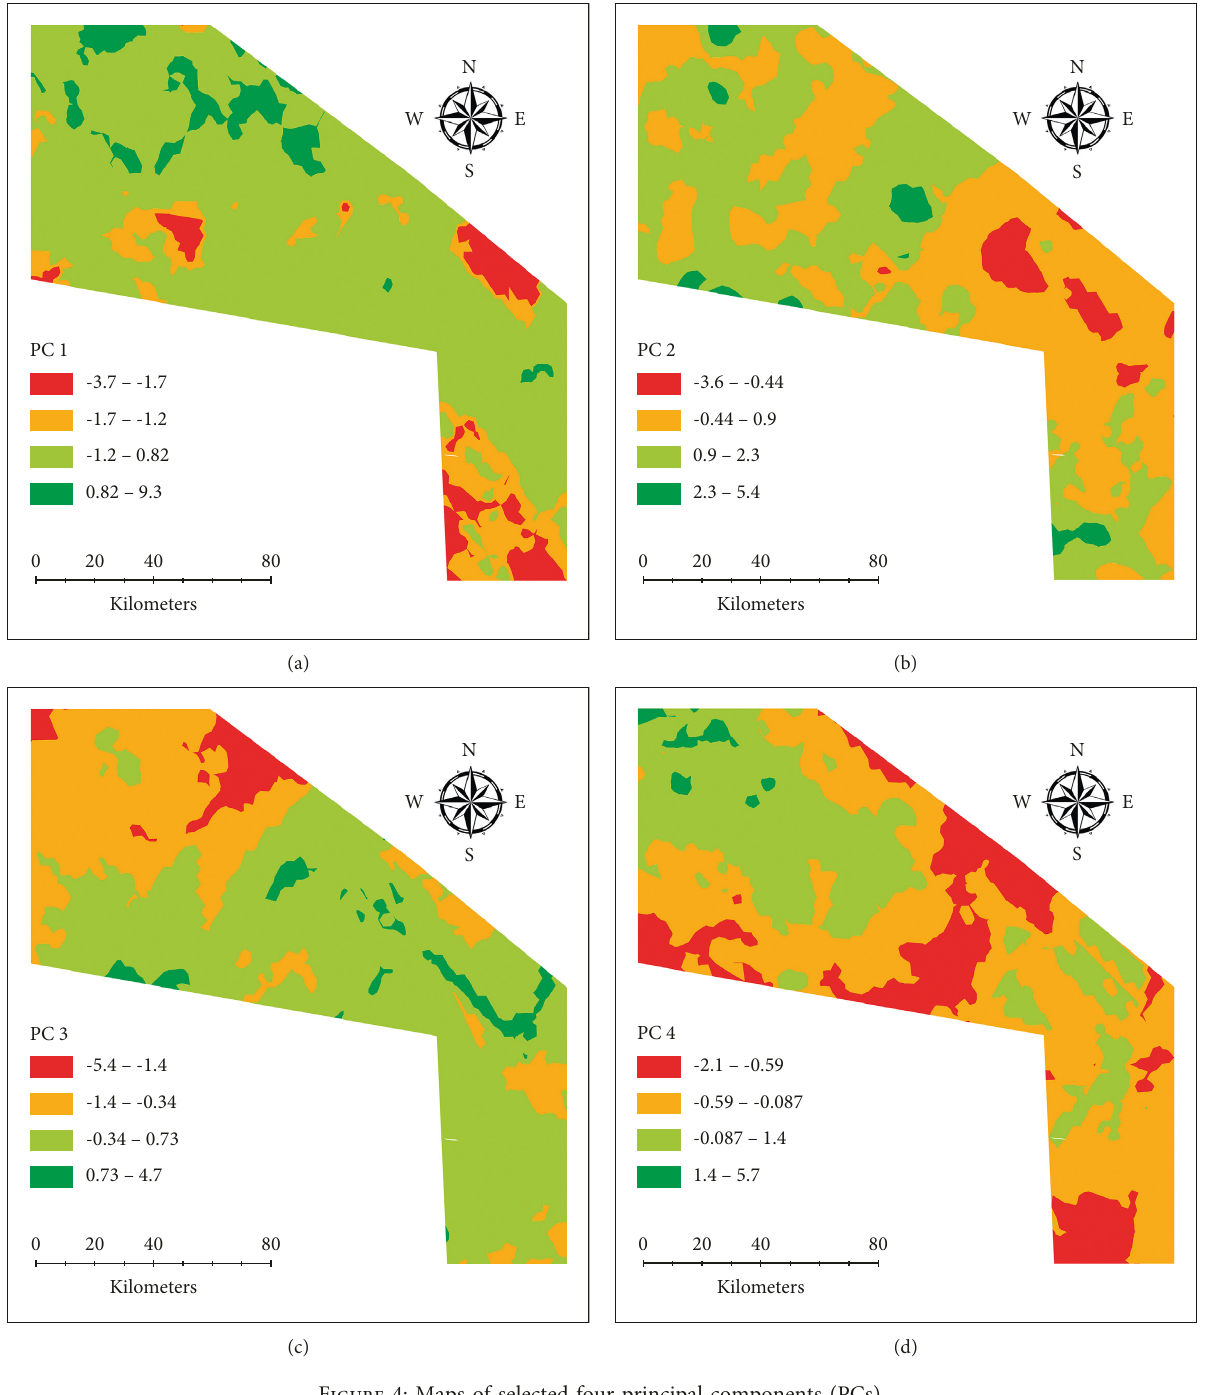
Figure 4: Maps of selected four principal components